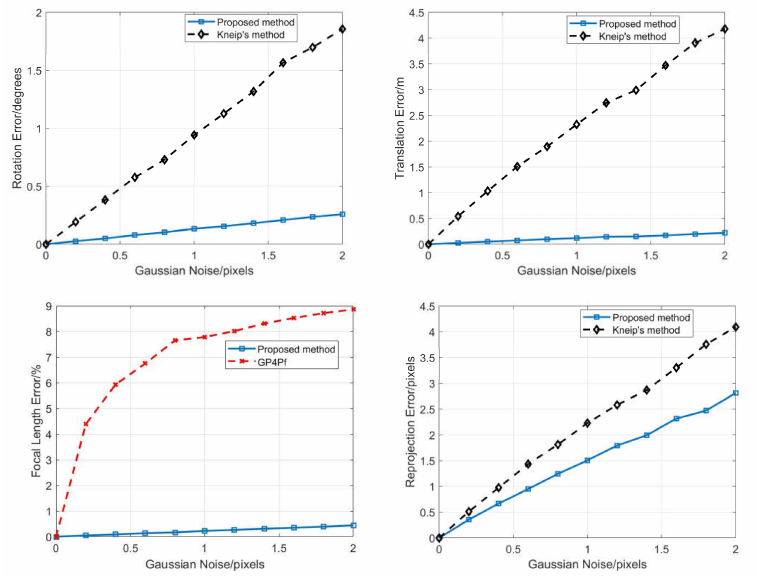
Figure 10. Average error of rotation ( top left ), translation ( top right ), focal length ( bottom left ) and reprojection ( bottom right ) for our proposed method (blue), Kneip’s method (black), and GP4Pf